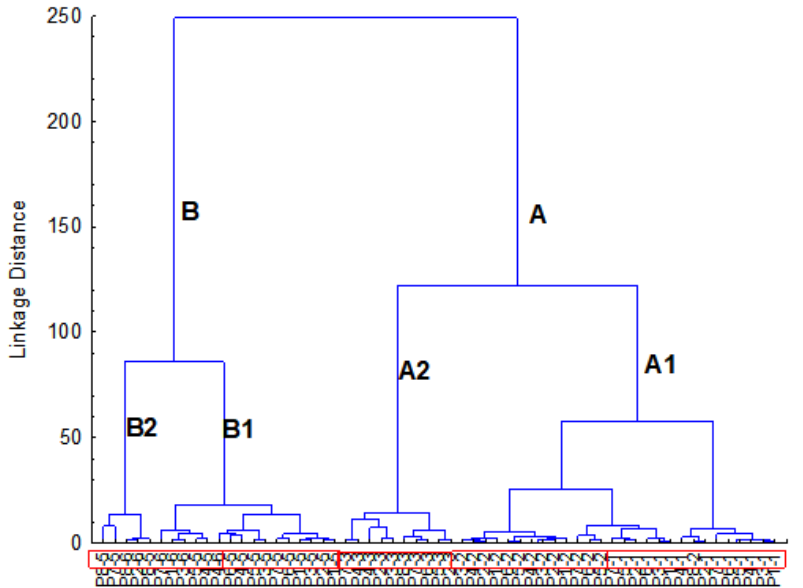
Figure 14. Hierarchical analysis (HCA) with the 10 main variables and 3 factors for Lake Paranoá reservoir data. The code in the x- axis represents: the sampling point (ex: P1) and the collection number (ex: 3- collection date: February 2017). Group A -samples from wet season; Group B-samples from dry season. Subgroup A1-early wet season samples; Subgroup A2-samples from the end of the wet season. Subgroup B1-grouped samples from June/2017 and Subgroup B2- samples from June and august/2017.